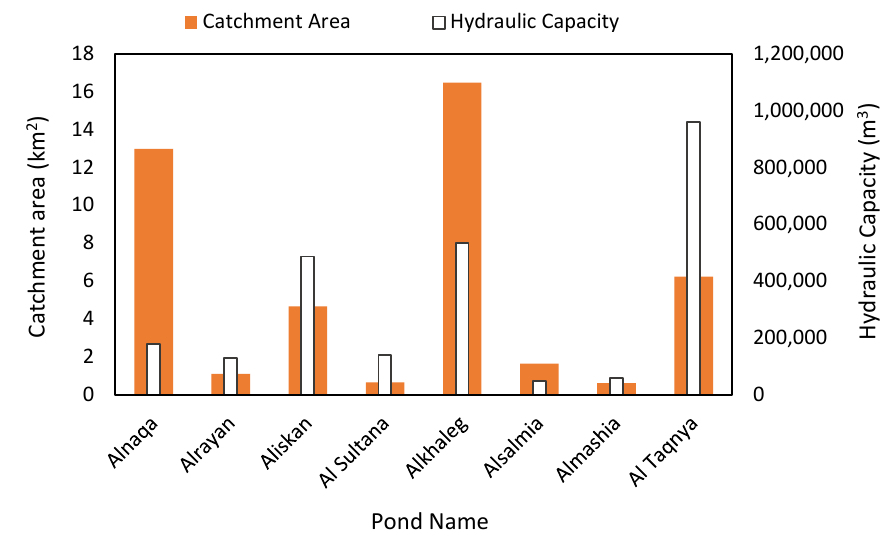
Figure 6. Characteristics of existing pond system in Buraydah